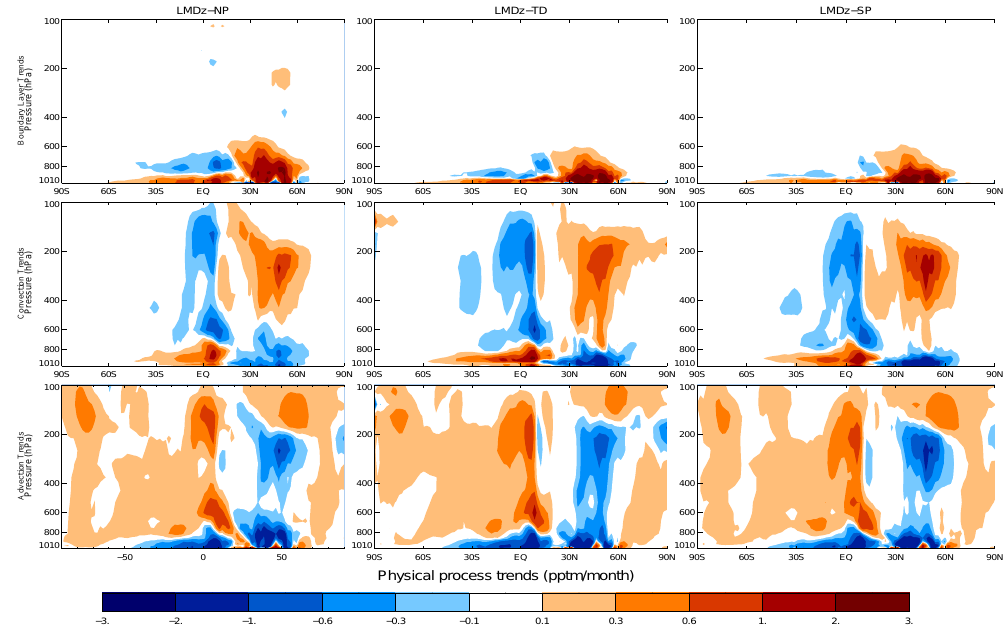
Figure 8. Zonal and monthly average of SF 6 boundary layer (top row), convection (centre row) and advection (bottom row) trends (in pptmmonth − 1 ) in July for NP (left column), TD (centre column) and SP (right column)